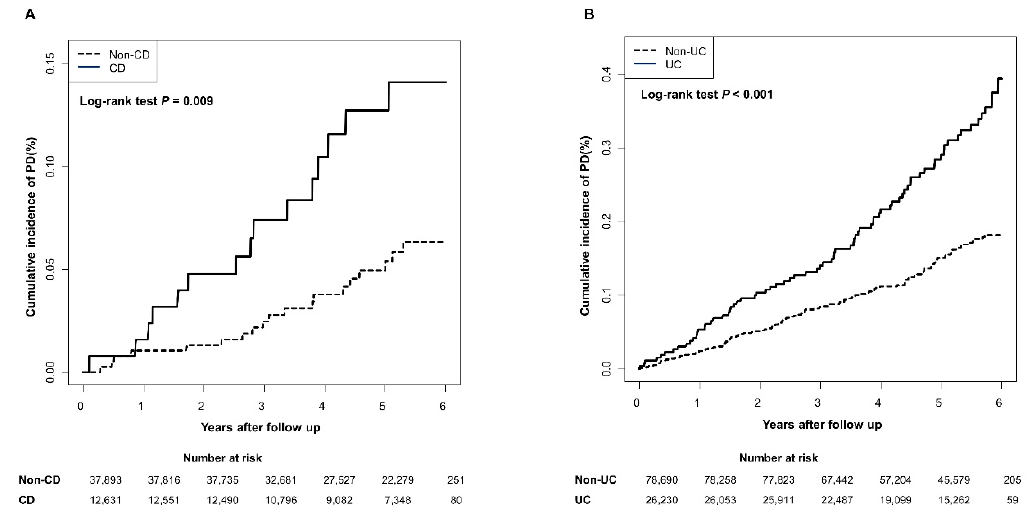
Figure 1. Kaplan – Meier plots show the cumulative incidence of Parkinson’s disease in patients with inflammatory bowel disease. ( A ) Patients with Crohn’s disease; ( B ) Patients with ulcerative